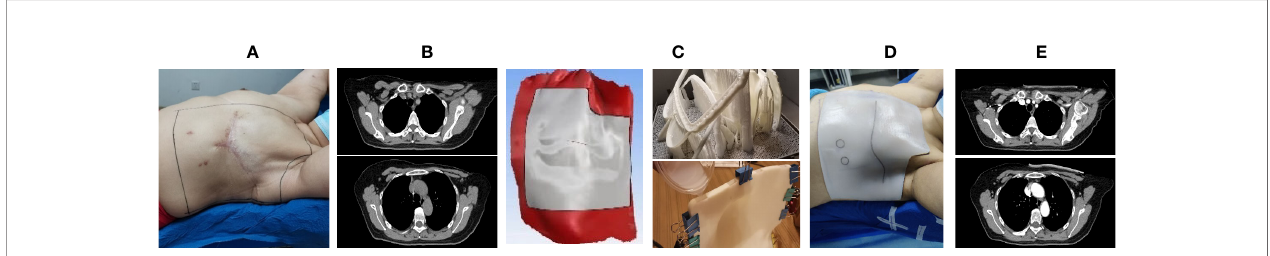
FIGURE 1 | The schematic of the manufacturing process of a three-dimensional (3D) bolus. (A) Patients were positioned in standards and their body contour was marked; (B, C) 3D-modeling software was used to create a patient-speci fi c bolus based on CT images and marks; (D) the fi tness of the 3D-printed bolus was veri fi ed; (E) a radiotherapy plan which referenced the second CT scan with the 3D bolus in the treatment planning system (TPS) was formulated.